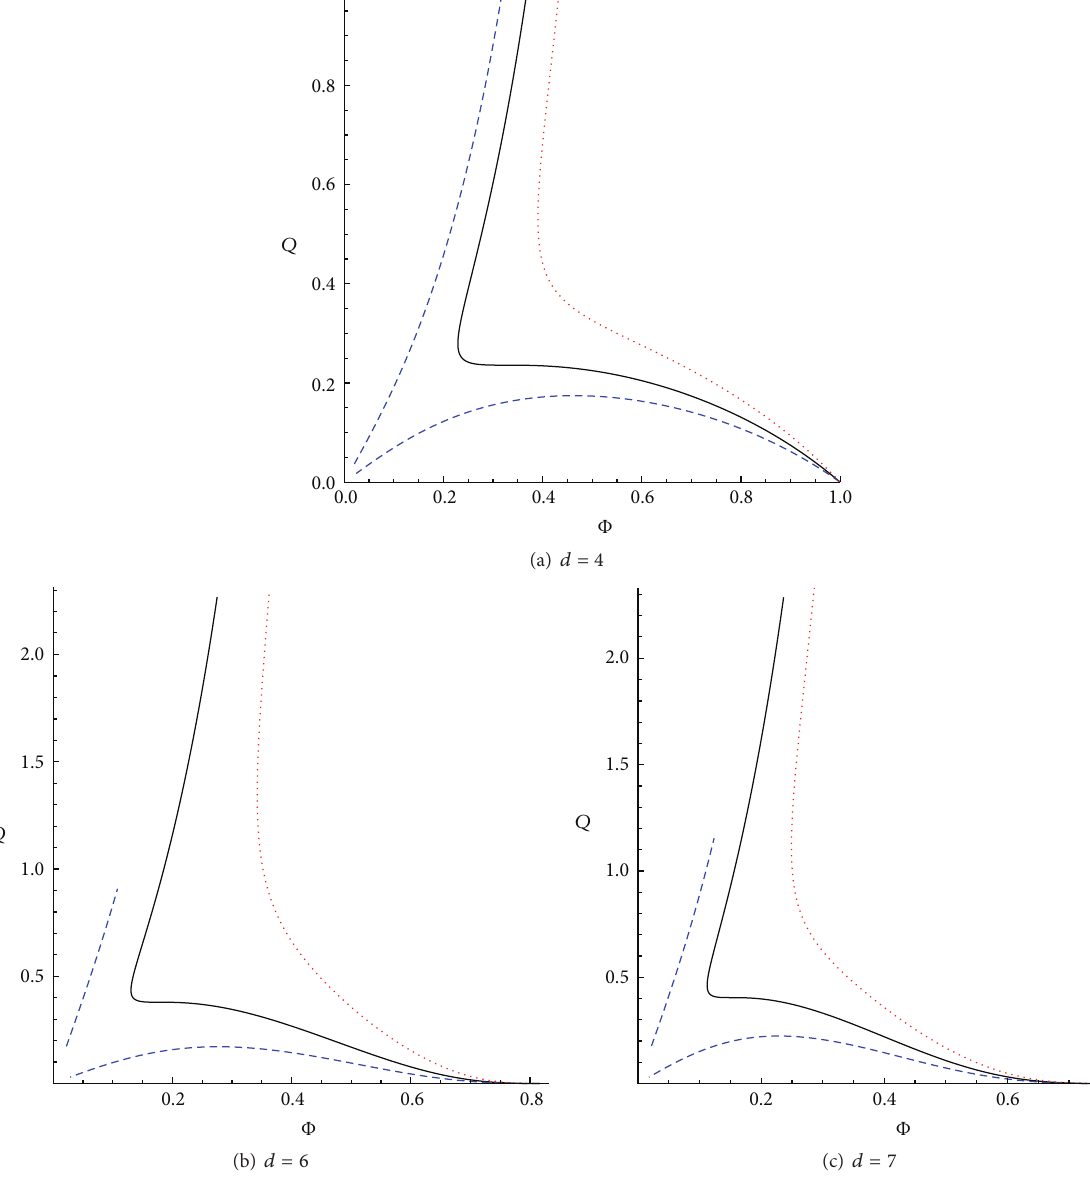
Figure 4: The 𝑄 - Φ curves for 𝑑 = 4, 6,7 , respectively. From top to bottom the curves correspond to the effective temperatures 0.7𝑇 loc , 𝑇 loc , and 1.4𝑇 loc